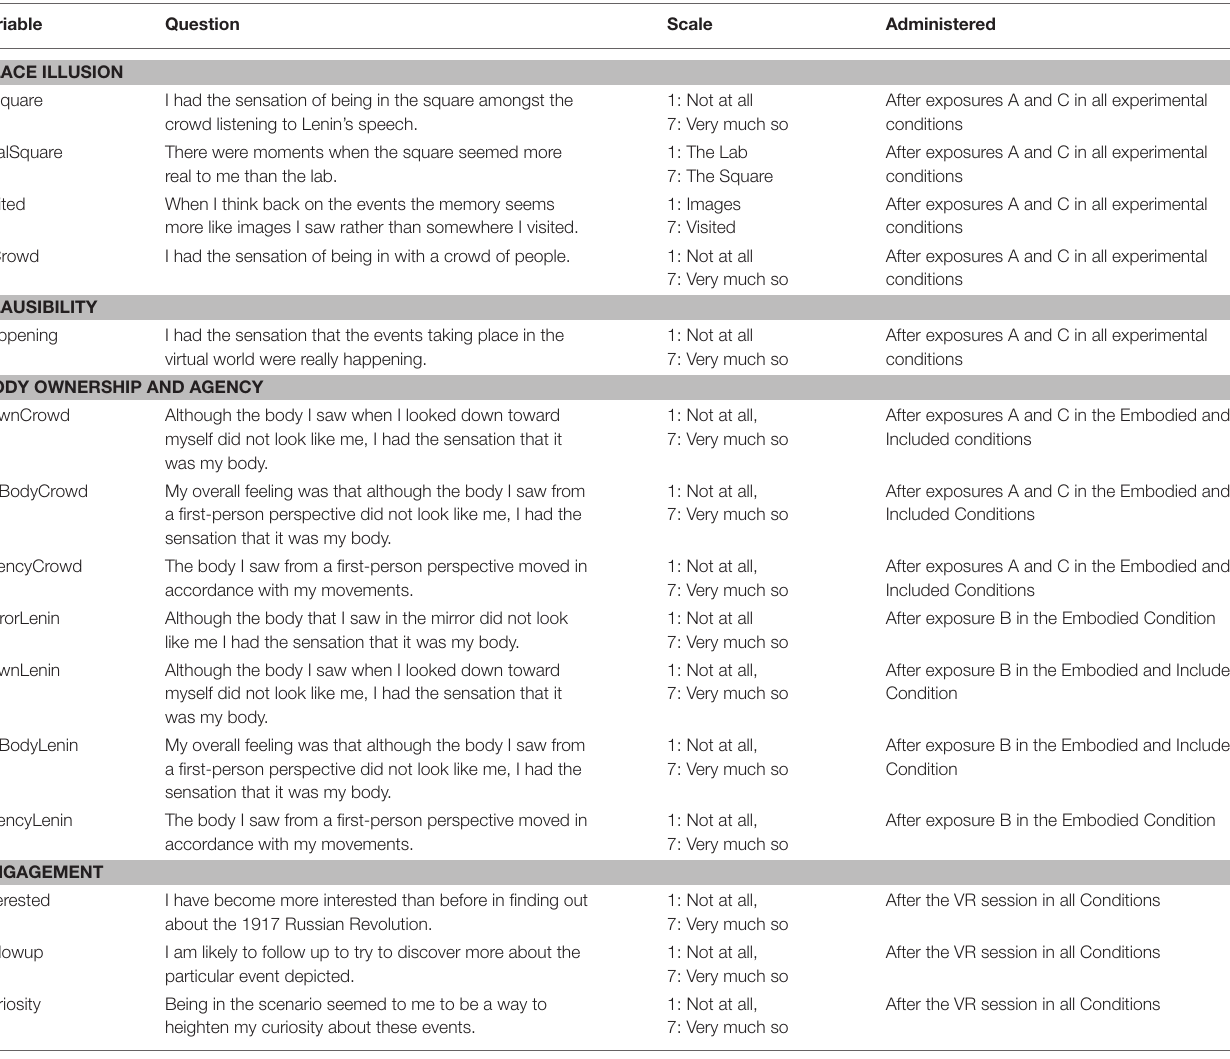
TABLE 1 | The questionnaires: each statement was assessed on a 1–7 Likert